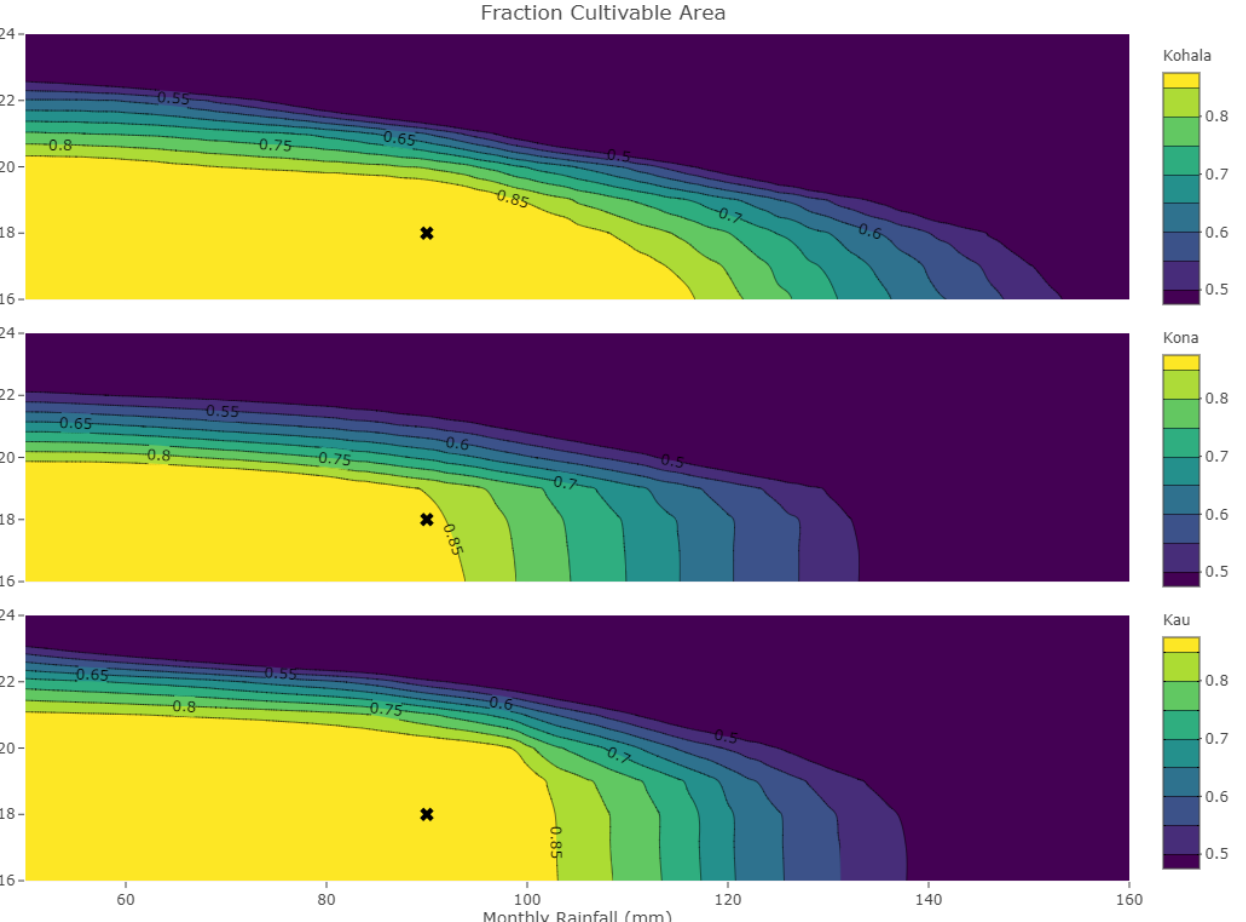
Figure A2.1 Fraction of field system that meets thresholds for monthly air temperature and monthly rainfall for at least one month of the year: Kohala (top), Kona (middle), and Ka ʻū (bottom). Monthly air temperature criterion (minimum) indicated on the y-axis and monthly rainfall criterion (minimum) indicated on the x-axis. Marker at rainfall = 90 mm and temperature = 18 ° C indicates the fixed thresholds used for visualizing seasonal cultivation